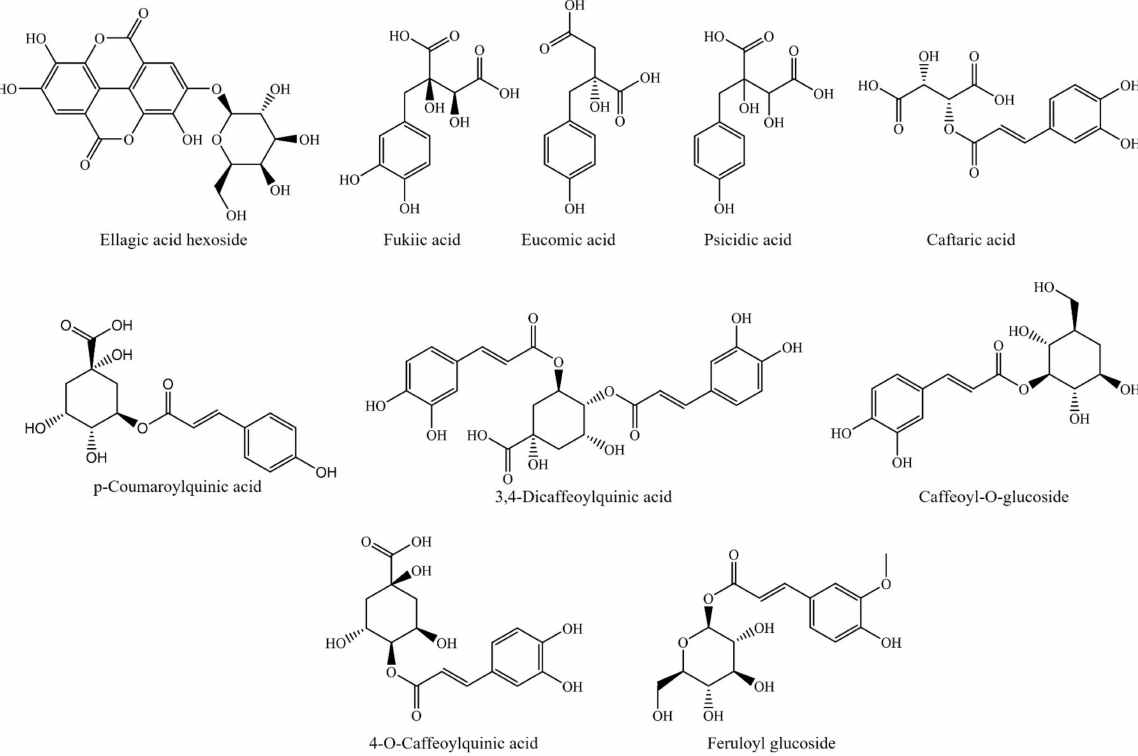
Figure 2. Current phenolic acids identified in the Agave